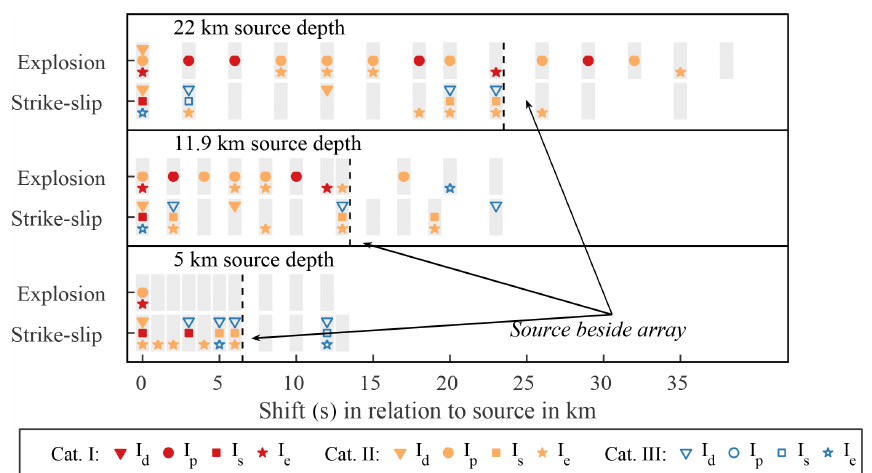
Figure 7. The location accuracy obtained with different shift distances ( s ) between the middle of the array and the source location. The dotted line denotes the point at which the array is no longer above the source. Three source depths were tested for the two source types, respectively. The locations achieved with the individual imaging conditions were ranked according to the categories from Fig. 2. Grey bars indicate set-ups that were tested. No symbol in the grey bar means that the localisation was unsuccessful. Symbol types and colours in the grey bars represent successful locations with the imaging condition sorted into the respective category.